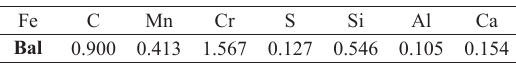
Table 4. Chemical composition by weight (wt.%) of the AISI 52100 steel disc 9 Fe